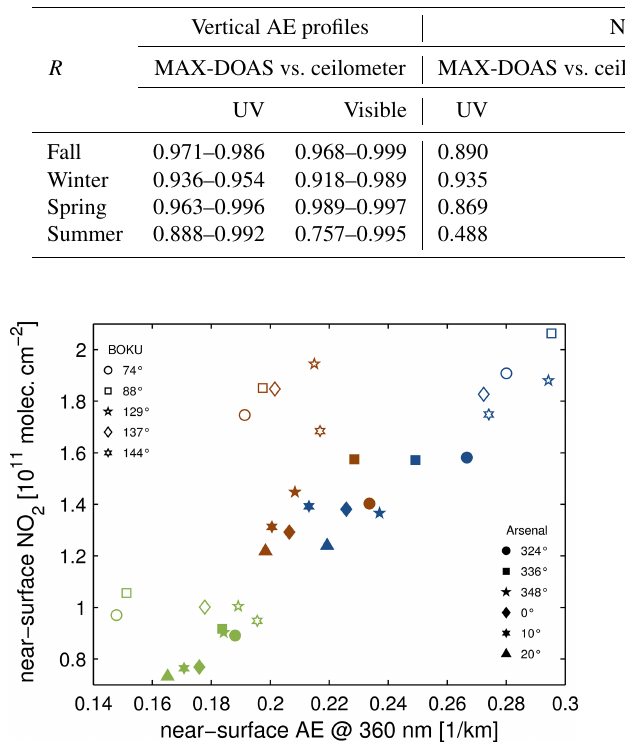
Figure 13. Same as Fig. 12 but for the near-surface retrieval prod- ucts AE and NO 2